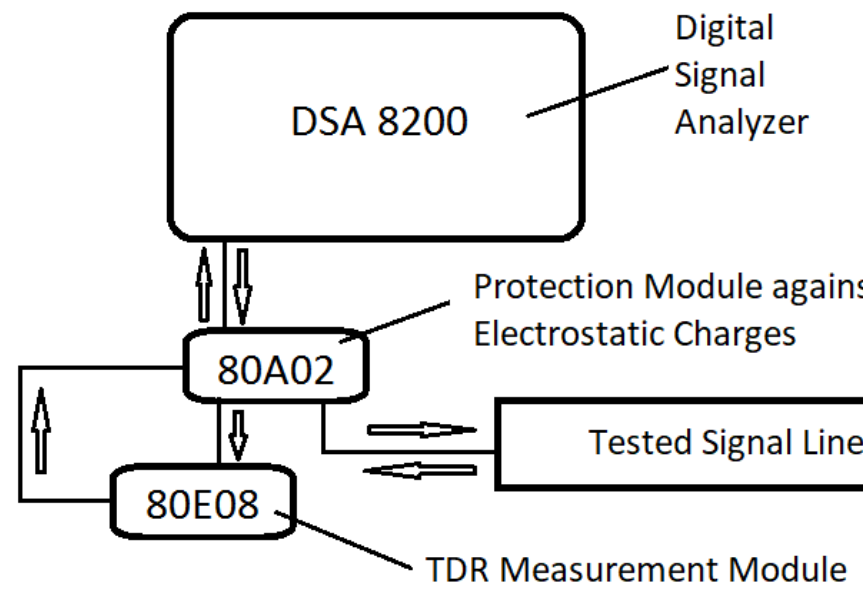
Figure 4. Block diagram of the measuring method for the TSL’s characteristic impedance .